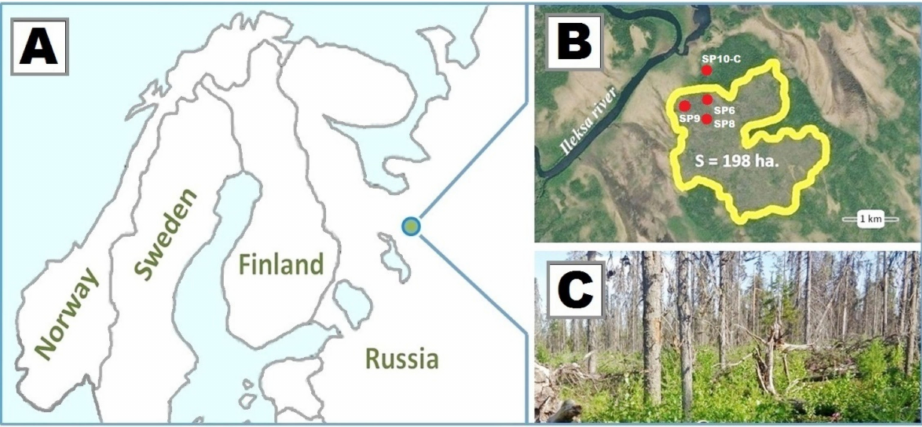
Figure 1. Location of the forest area burnt and sample plots (SP) in the Vodlozersky National Park ( A , B ). View of the spruce forest after the fire in 2011 ( C